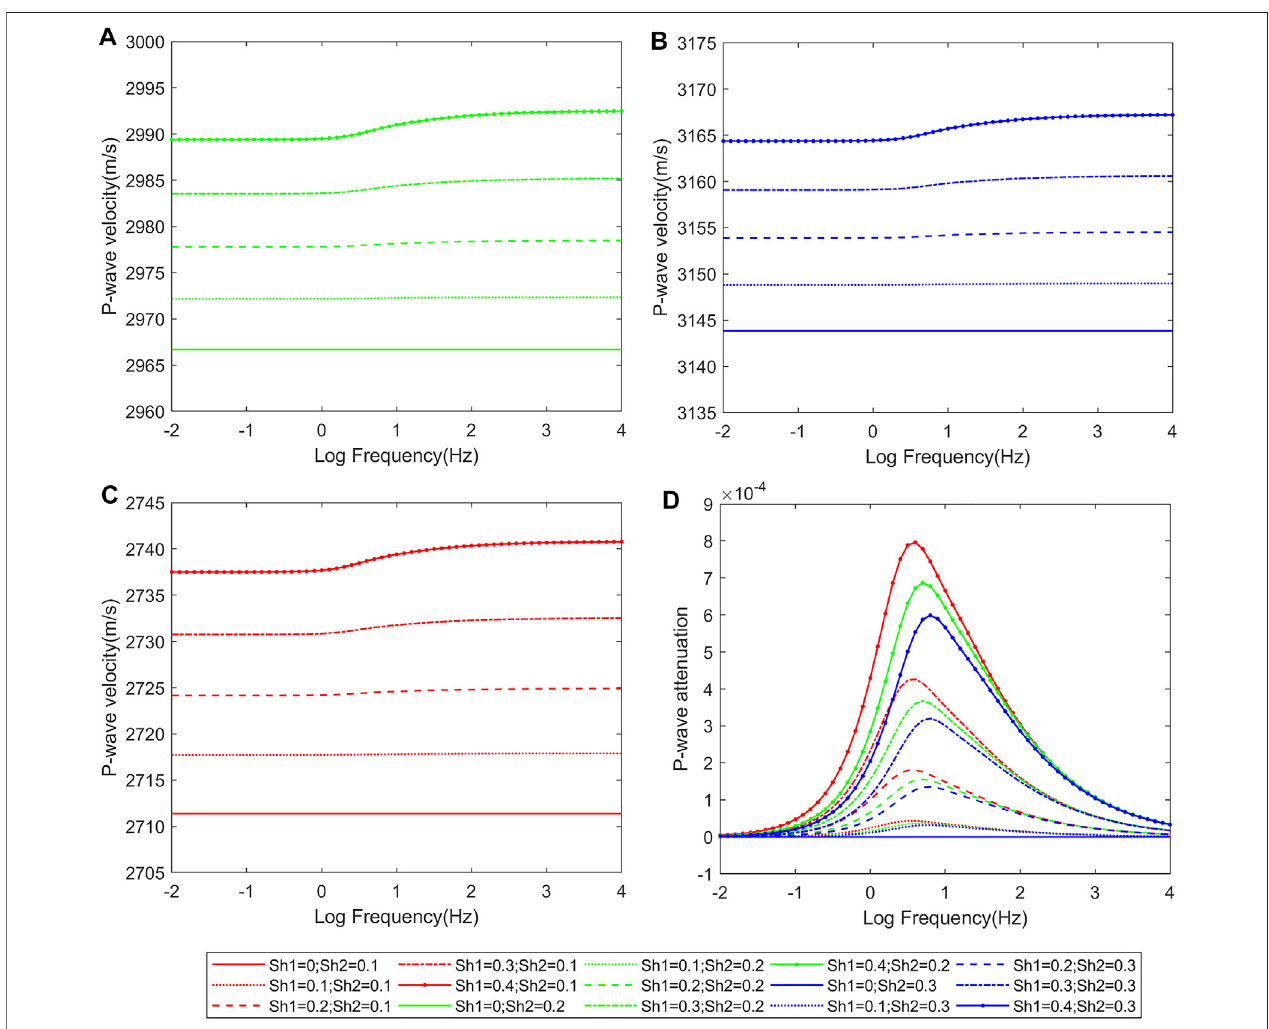
FIGURE 4 | P-wave velocity (A-C) and P-wave attenuation (D) vs. frequency curves at different hydrate contents in mode C.